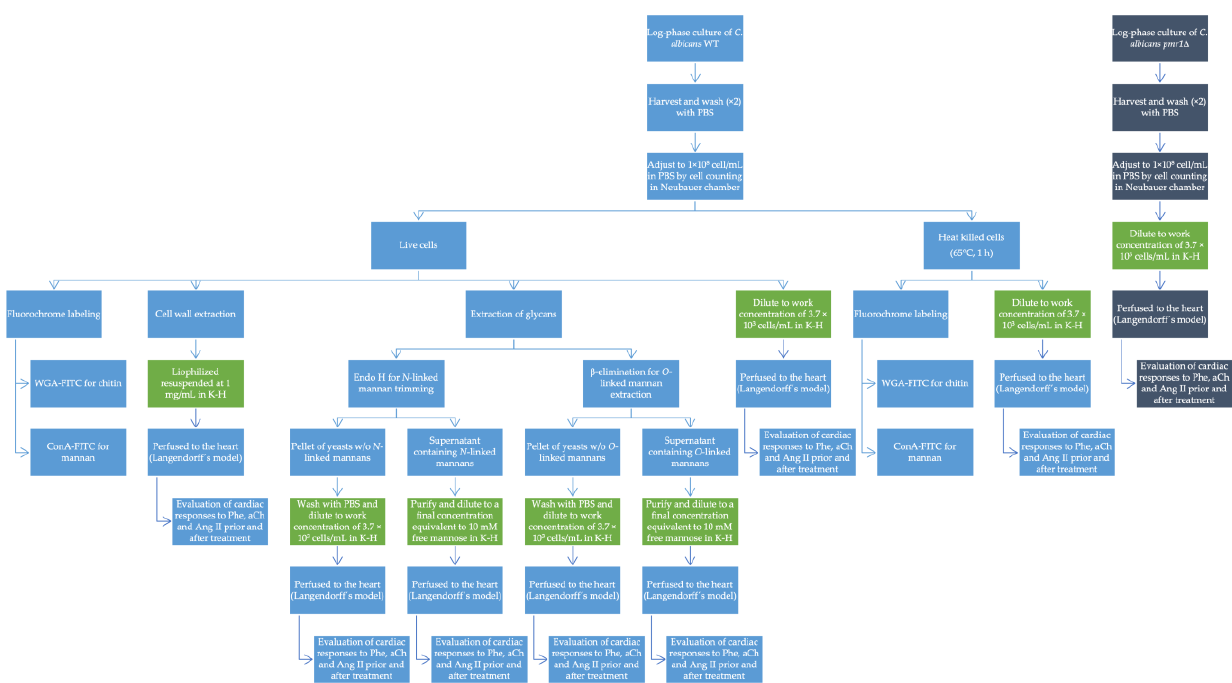
Figure 2. Diagram showing the general flow of the experimental procedures used in this study. Experiments performed with C. albicans WT are shown in light blue boxes. Experiments performed with C. albicans pmr1 ∆ are shown in dark blue boxes. The work suspensions/solutions for the treatments described in Table 1 are shown in green